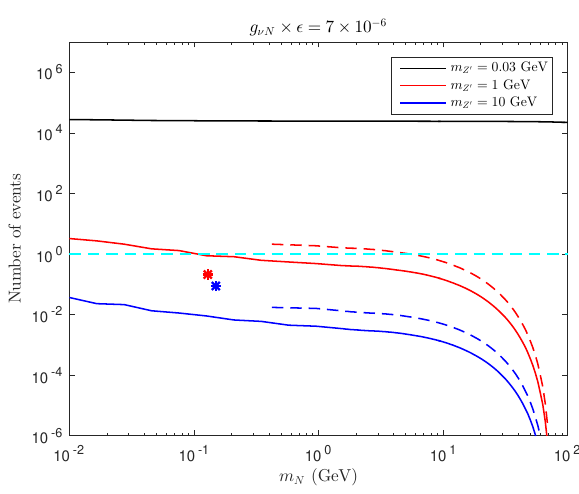
Figure 2 . Number of new physics events at FASER ν during LHC run III vs. m N . The solid curves show the number of N produced inside the detector ( N HESE ). The dashed curves show the total number of the µ ¯ µµ ¯ µ events coming from production of N both inside the detector and en-route rock and concrete ( N HESE + N through-going ). The dashed curves are clipped at m N = 4 m µ as for lighter N , the signal of µ ¯ µµ ¯ µ for through-going muons cannot be obtained. We have set g νN × (cid:15) = 7 × 10 − 6 and have taken the flux of neutrinos from figure 4 of [1]. The black, red and blue curves respectively correspond to m Z 0 = 0 . 03 , 1 and 10 GeV . The blue and red dots show the number of events corresponding to the best fit solution of MiniBooNE taken from ref. [7] with (cid:15)g νN = 2 . 7 × 10 − 6 , m N = 150 MeV, m Z 0 = 1 . 2 GeV and from ref. [8] with (cid:15)g νN = 2 × 10 − 8 , m N = 130 MeV, m Z 0 = 30 MeV, respectively. The cyan horizontal dashed line corresponds to the number of events equal to